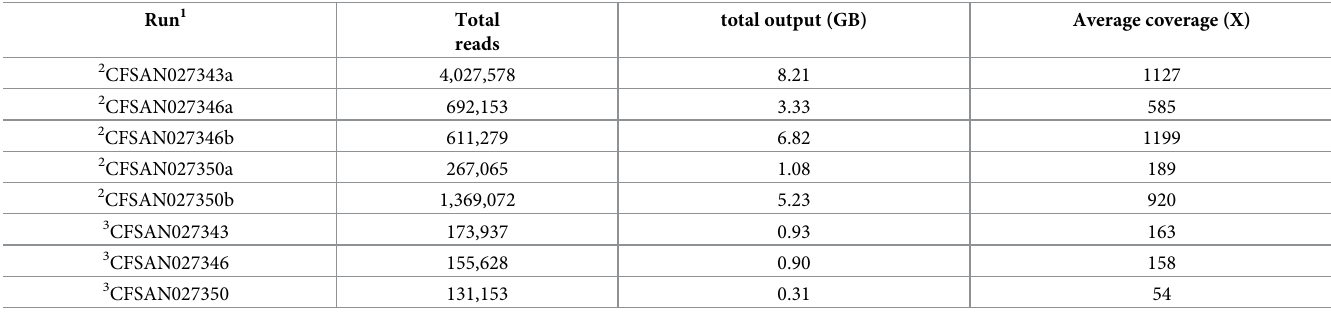
Table 3. STECs MinION sequencing output statistics by replicate and library